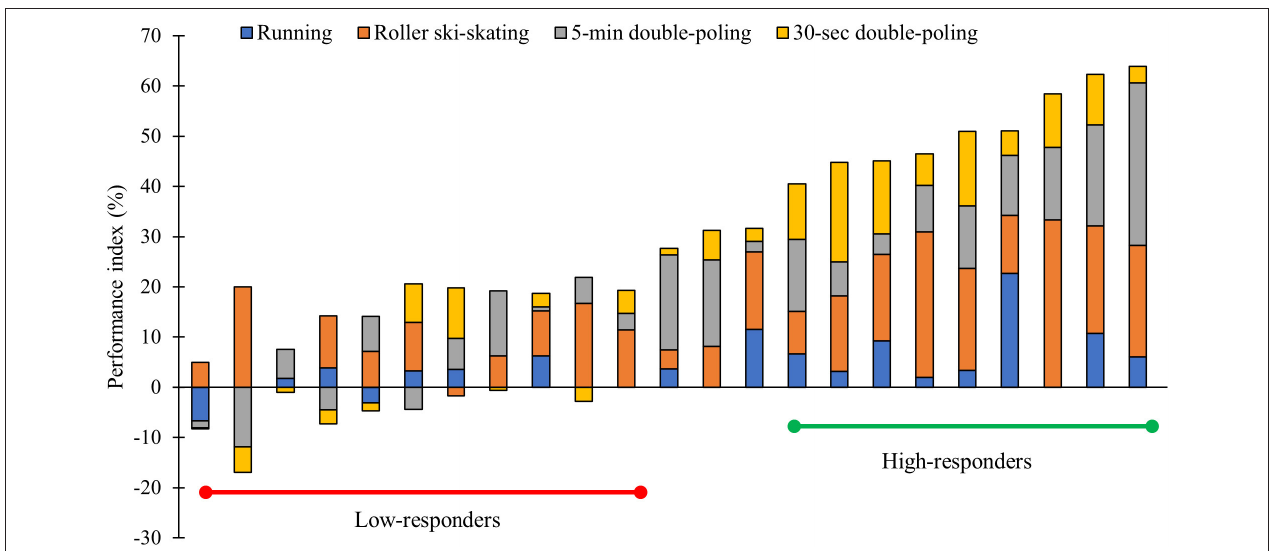
FIGURE 1 | Frequency distribution of the individual response magnitude (performance index) based on pre- to post changes in peak speed during a VO 2max test treadmill running and VO 2peak test treadmill roller-ski skating in addition to average power output during a 5-min and 30-s performance test double-poling ergometry in 23 endurance transfer athletes following a 6-month XC ski-specific training